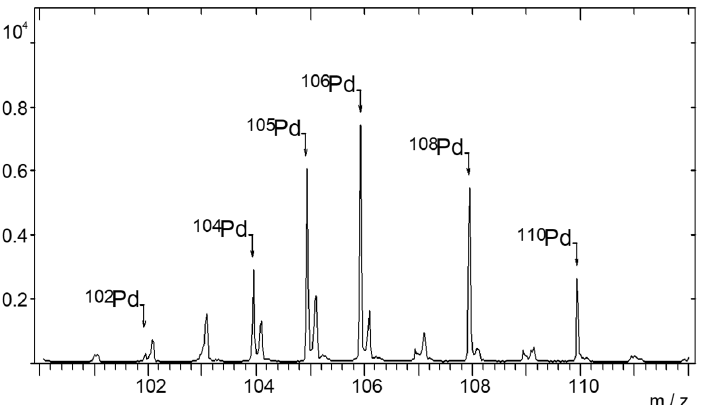
Figure 13. TOF ‐ SIMS spectrum of palladium isotope ions emitted from the surface of Pd/TiO 2 /Ti catalyst obtained with adsorption of Pd ions from 2%Pd wt. solution.